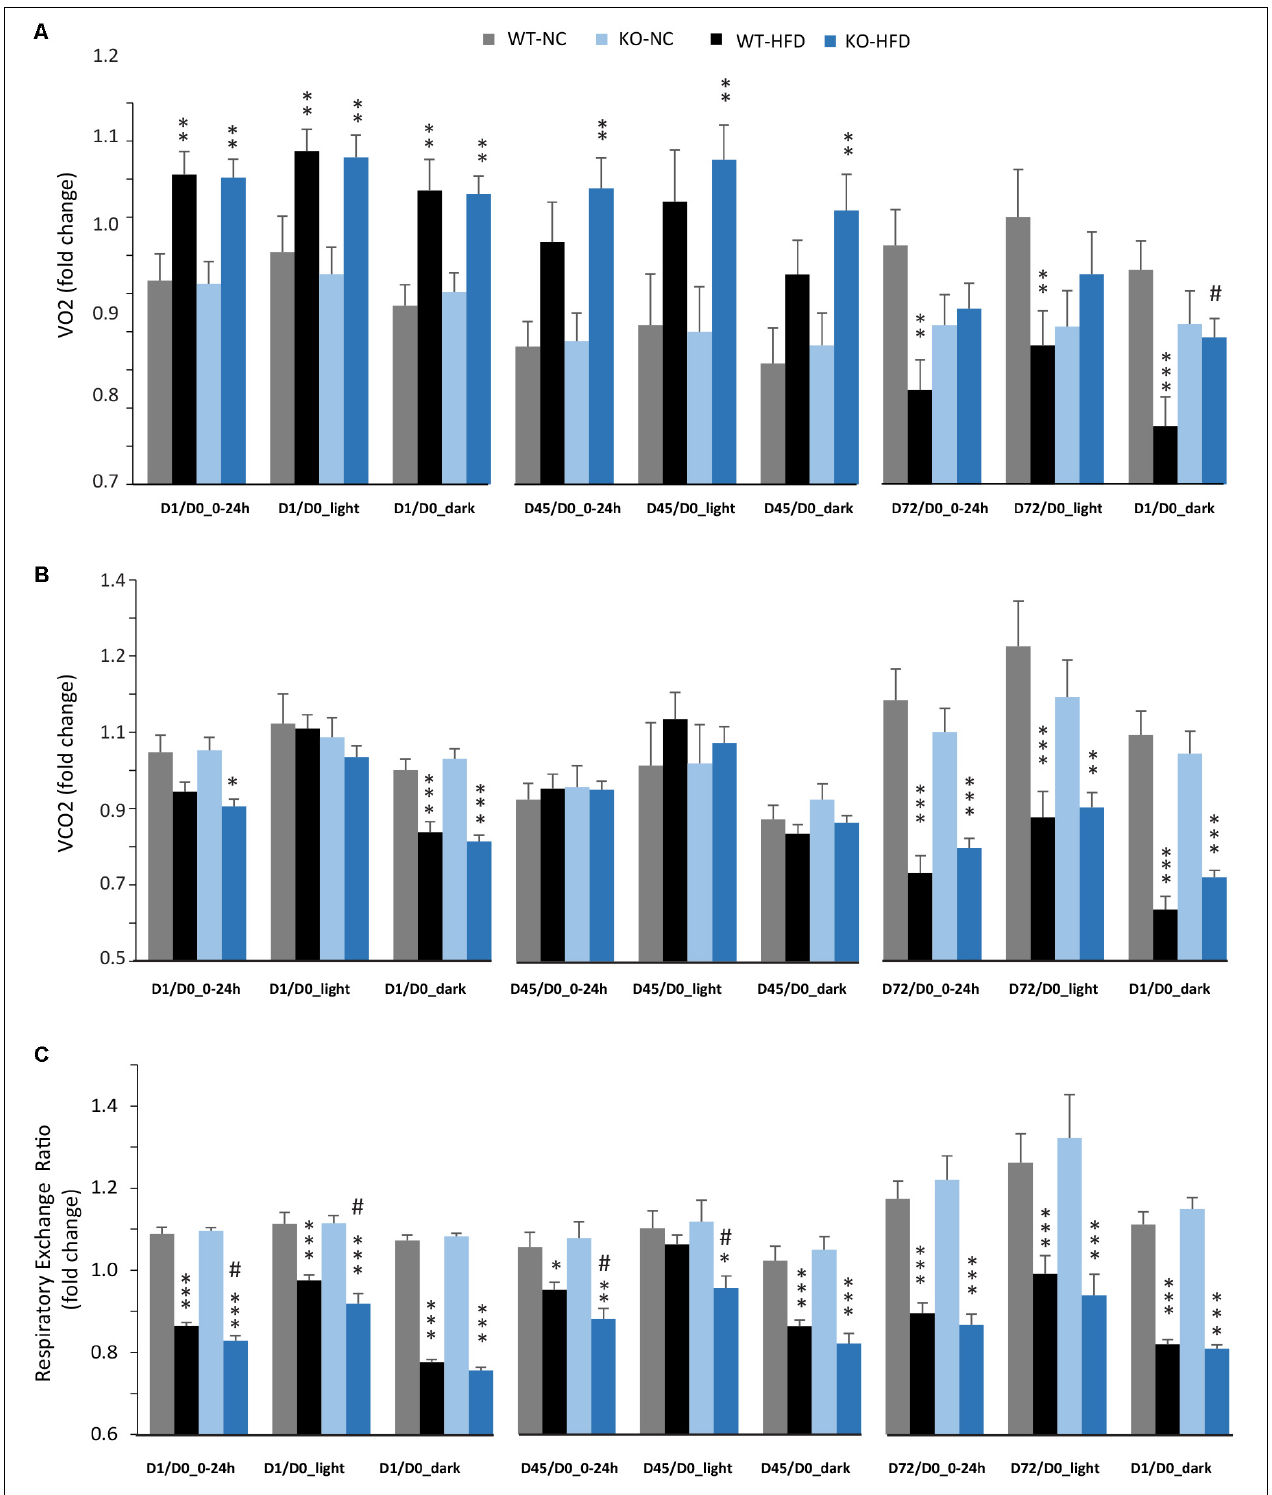
FIGURE 6 | Modulation of VO 2 , VCO 2 , and RER during HFD feeding, impact of mPGES-1 deletion. Calorimetric analyses were performed at three time points during the feeding period. Each set of analysis comprised 3 days of monitoring; mean values were compared to baseline data obtained for each animal at the beginning of the experiment (D0) and expressed in fold changes for VO 2 (A) , VCO 2 (B) , and RER (C) . Data shown are mean ± SEM. ∗ , significantly different from NC; # , significant difference between WT-HFD and KO-HFD; ∗ p < 0.05; ∗∗ p < 0.01; ∗∗∗ p < 0.001; and same statistical parameters apply to # symbol.